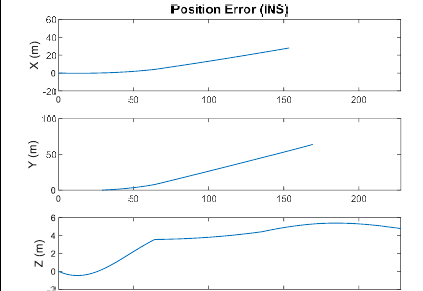
Table 6. Analysis for position accuracy